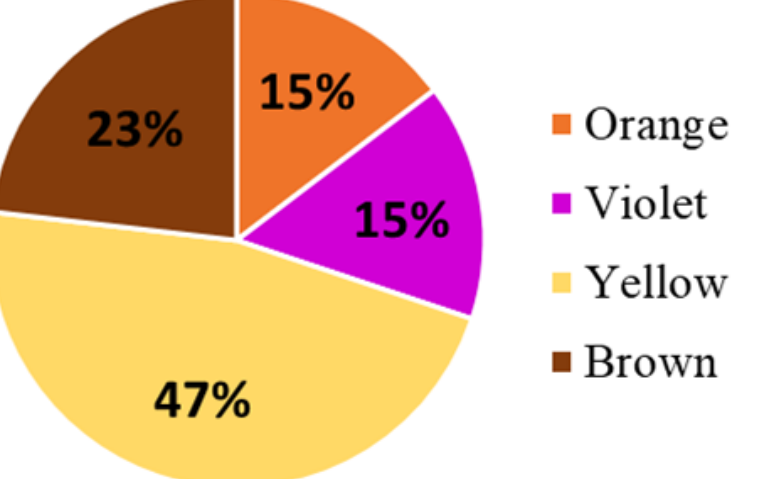
Figure 2. Numbers of proteins identified based on three or more peptides in bee pollen according to their color.